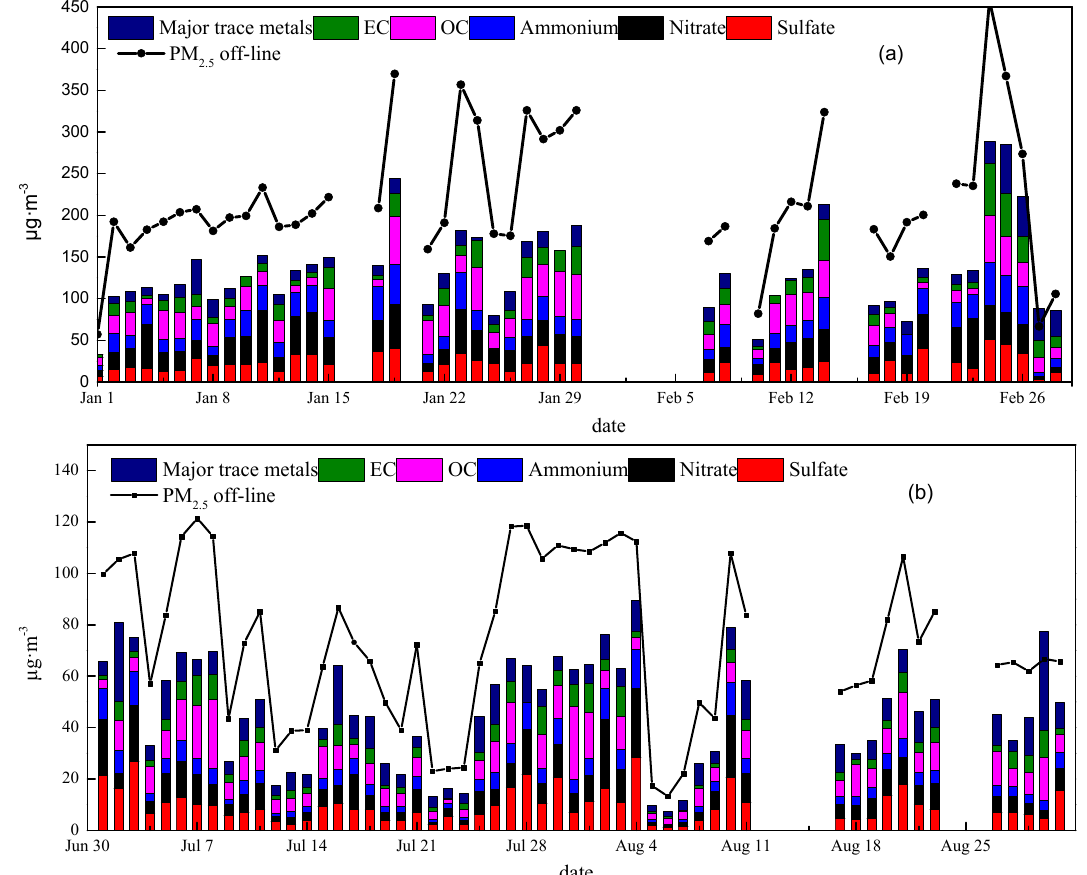
Figure 4. The time series of major PM 2.5 components in ( a ) the cold period and ( b ) the warm period.